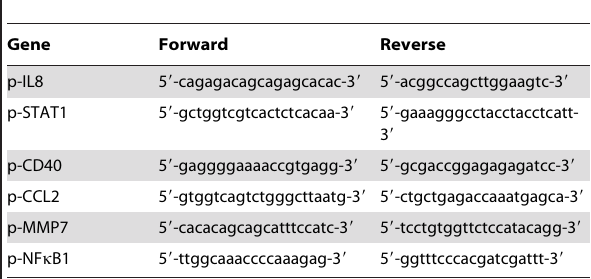
Table 2. Primer sequences used for ChIP experiments.